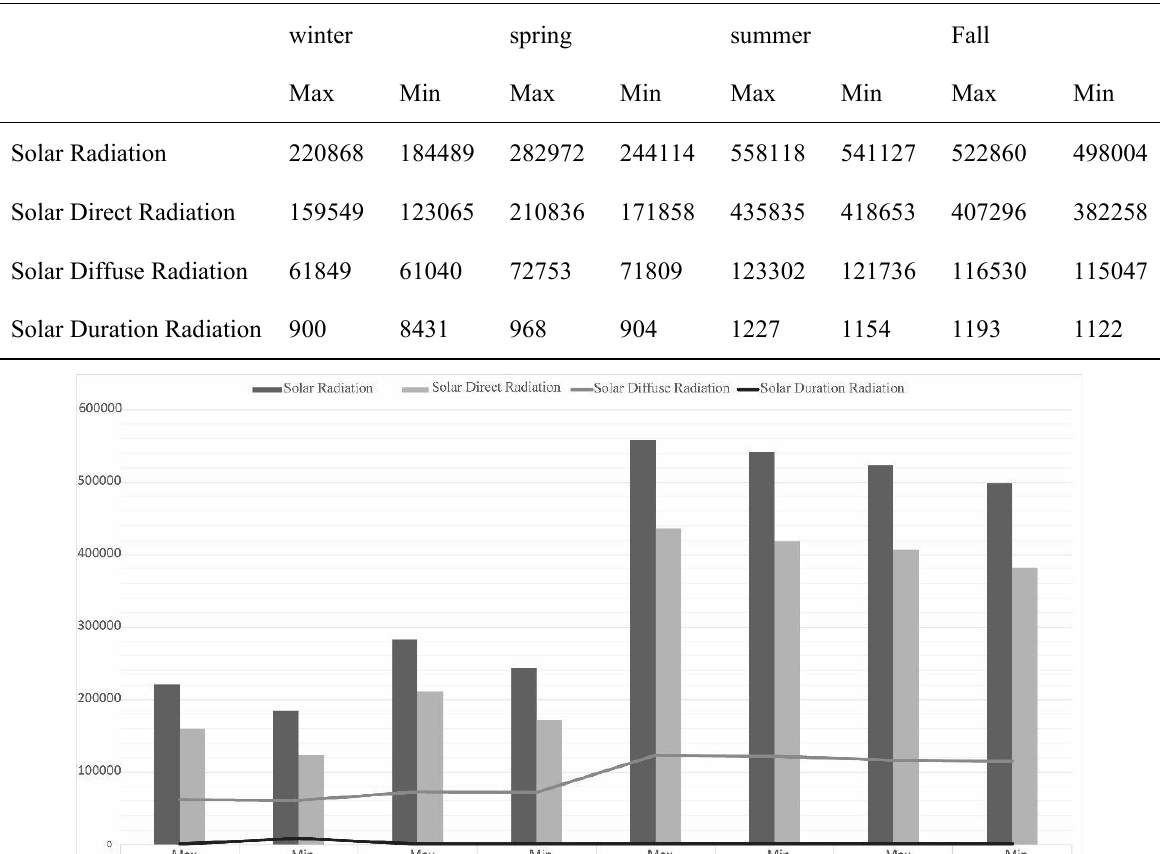
Table 2. The amount of total, direct, and diffused radiation of the sun in different seasons of the year